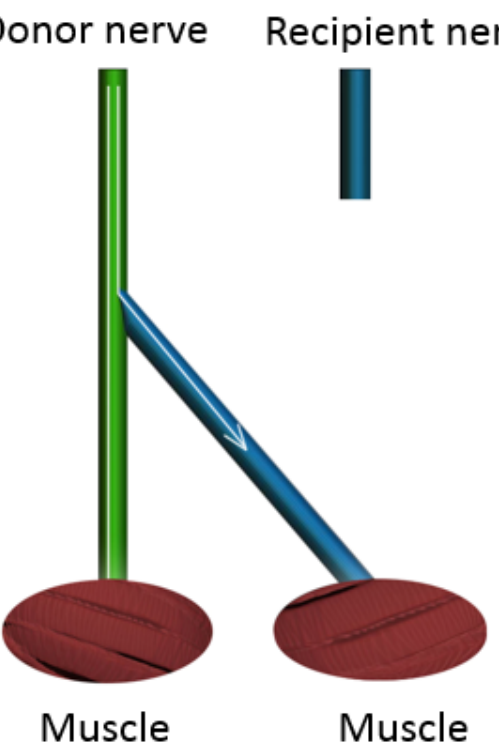
Figure 5. End-to-side nerve repair. Traditional end-to-side nerve coaptation involves the coaptation of the distal denervated stump into the side of the intact donor nerve. Any axons that are present in the distal recipient nerve stump exclusively originate from the donor nerve.